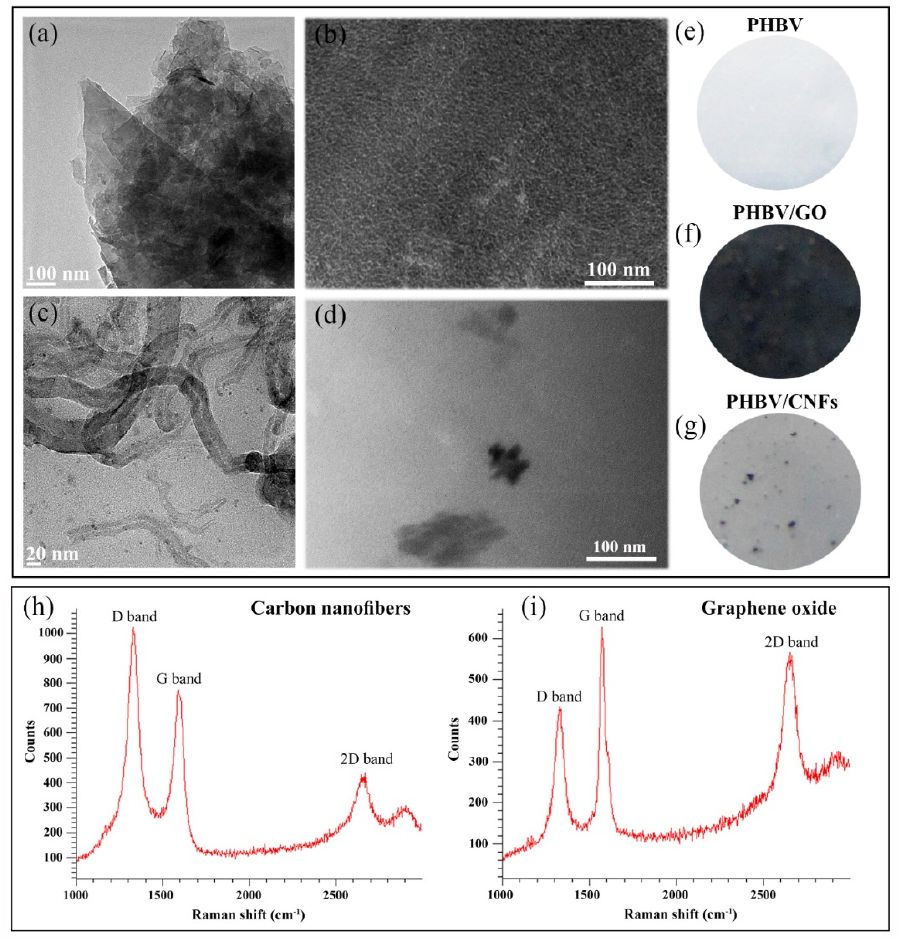
Figure 1. High-resolution transmission electron microscopy images of 2D graphene oxide (GO) nanosheets ( a ) and 1D carbon nanofibers (CNFs) ( c ), transmission electron microscopy images of PHBV/GO ( b ) and PHBV/CNFs ( d ), and photographs of the PHBV ( e ), PHBV/GO ( f ) and PHBV/CNFs ( g ) films. Reprinted with permission from ref. [43]. Copyright 2020 Elsevier. Raman spectra of CNFs ( h ) and GO nanosheets ( i ). Reprinted with permission under a Creative Commons CC BY 4.0 License from ref [60]. Copyright 2020 MDPI.